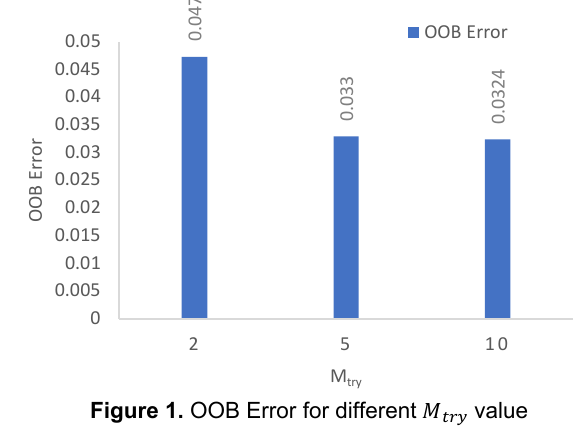
Figure 1. OOB Error for different 𝑀 𝑡𝑟𝑦 value